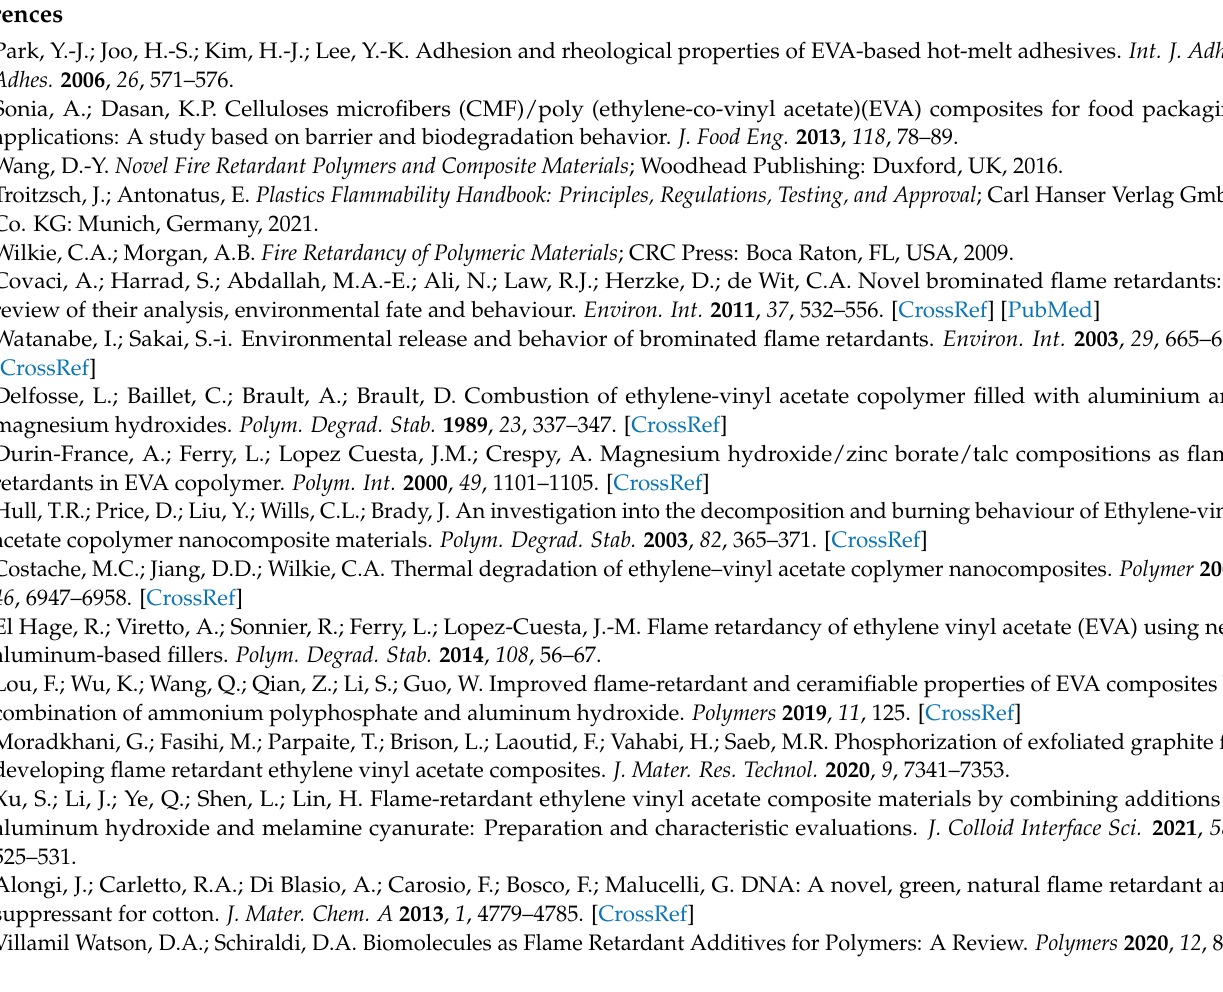
(C) and BC high (D), Table S1: results from thermogravimetric analyses in nitrogen and in air for BC powders, Table S2: results from thermogravimetric analyses in air and in nitrogen for EVA and its compounds; Table S3: average results of vertical burning tests for EVA and EVA/BC